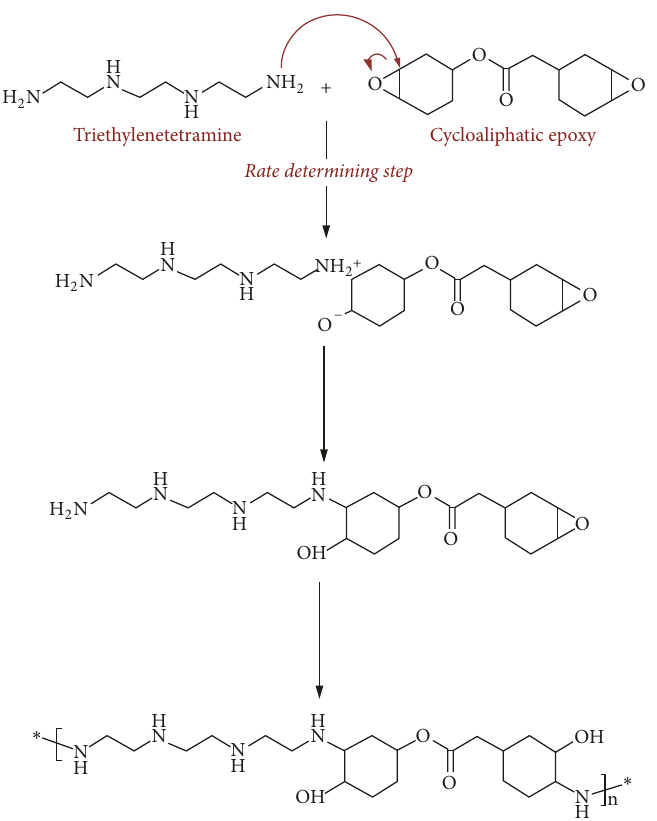
Scheme 1: Cycloaliphatic epoxy-amine curing reaction mechanism.